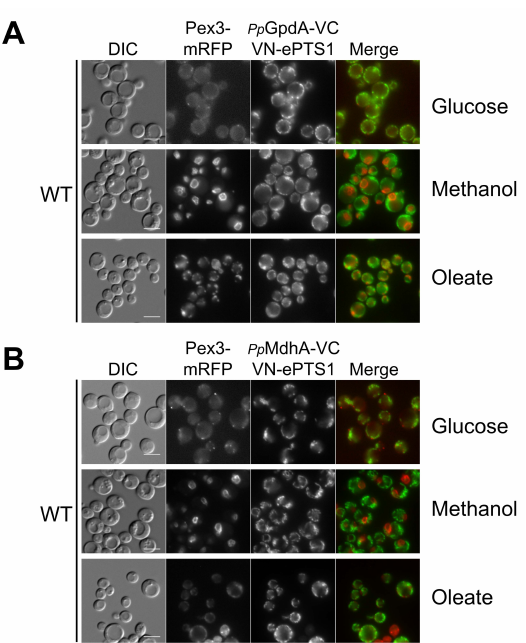
Figure 4. Localization of Pp GpdA and Pp MdhA in wild-type cells using the divergent BiFC assay. Strains were grown in glucose, methanol, and oleate overnight. Peroxisomes were visualized using Pex3-mRFP. ( A ) Pp GpdA-VC; ( B ) Pp MdhA-VC. Bars: 5 µ